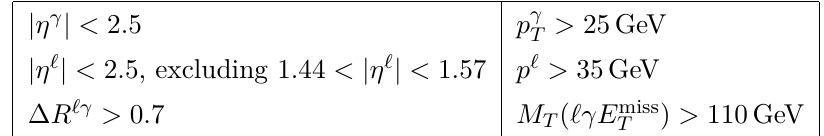
Table 7 . Fiducial cuts for theoretical predictions of the signed rapidity difference at 7 TeV.